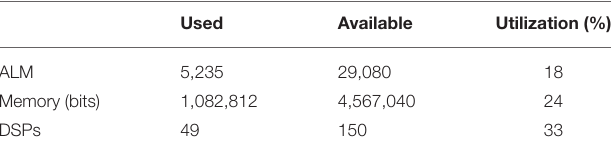
TABLE 1 | Device utilization